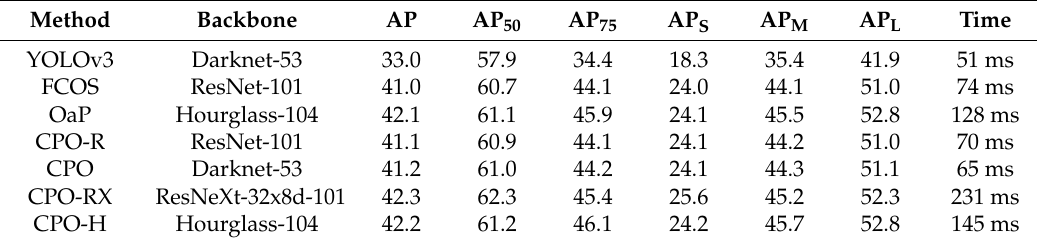
Table 1. Comparison of backbone outputs. The backbone of (center point proposal) CPO-R is ResNet-101, the backbone of CPO-RX is ResNeXt-32x8d-101, the backbone of CPO-H is Hourglass-104 and the backbone of CPO is Darknet-53.